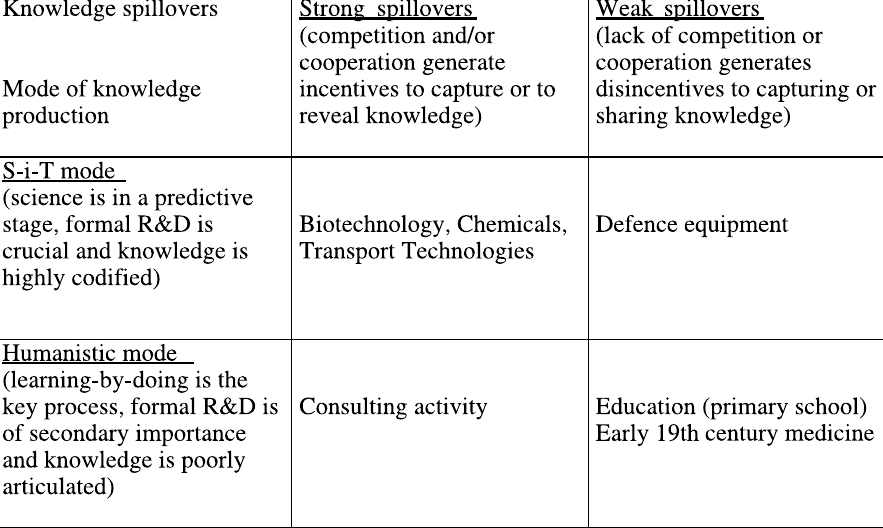
Figure 1. Four types of sectoral knowledge